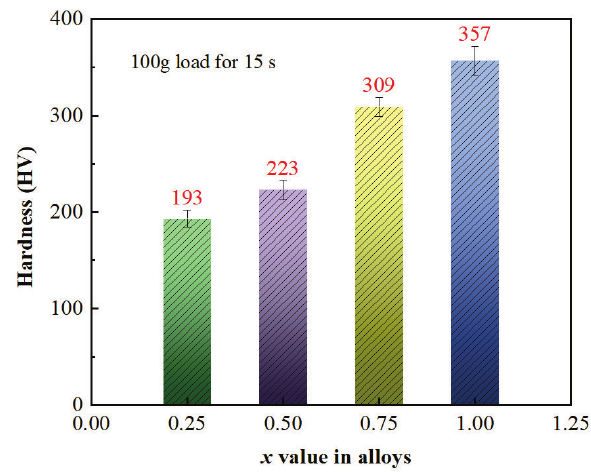
Figure 6. Relationship between Vickers microhardness and Mo content in CoFeNiMnMo x ( x = 0.25, 0.5, 0.75 and 1.0) alloys. Table 4. Room-temperature compressive properties of the studied CoFeNiMnMo x alloys and other reported CoCrFeNi-based and CoCrCuFeNi-based alloys. Alloys (cid:919) 0.2 (MPa) (cid:919) f (MPa) (cid:905) f (%) Reference CoFeNiMnMo 0.25 187 – > 80 This study CoFeNiMnMo 0.50 261 – > 80 This study CoFeNiMnMo 0.75 394 – > 80 This study CoFeNiMnMo 1.00 531 – > 80 This study CoFeNiMn 155.8 > 50